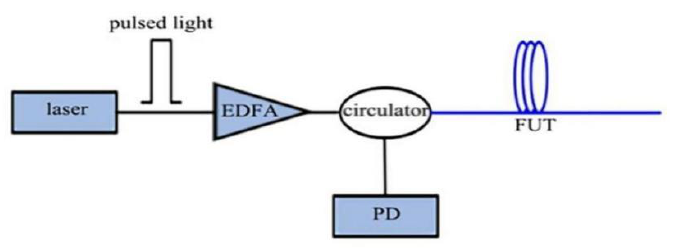
Figure 2. OTDR structure diagram.